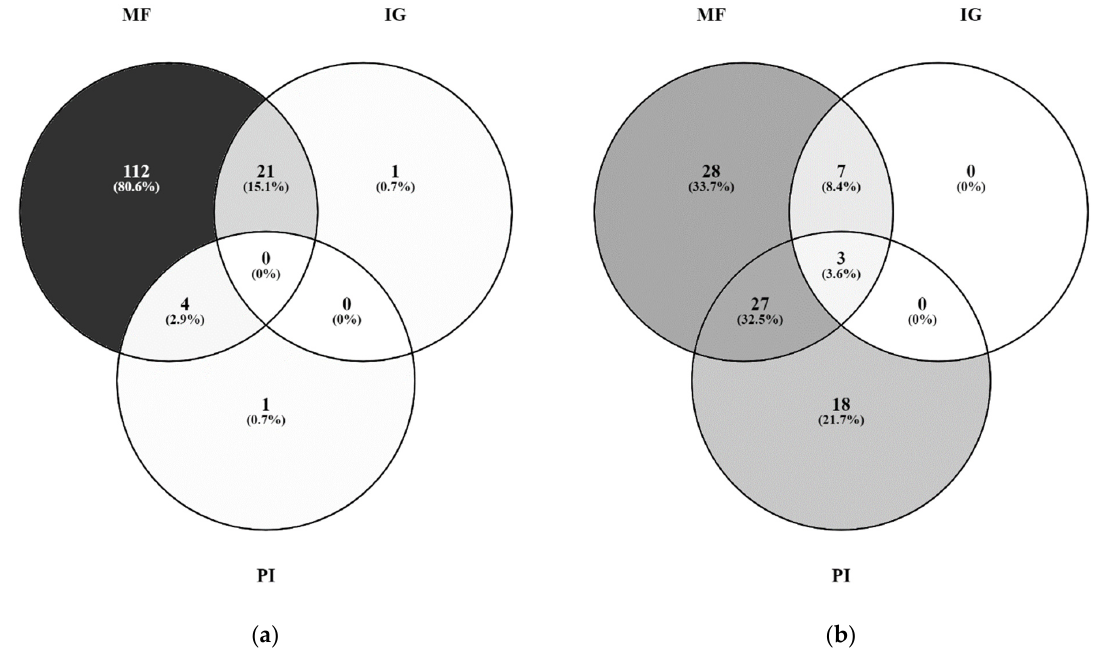
Figure A1. Depicted are Venn’s diagrams of histological growth patterns of ( a ) small and ( b ) large duct type iCCA [45].